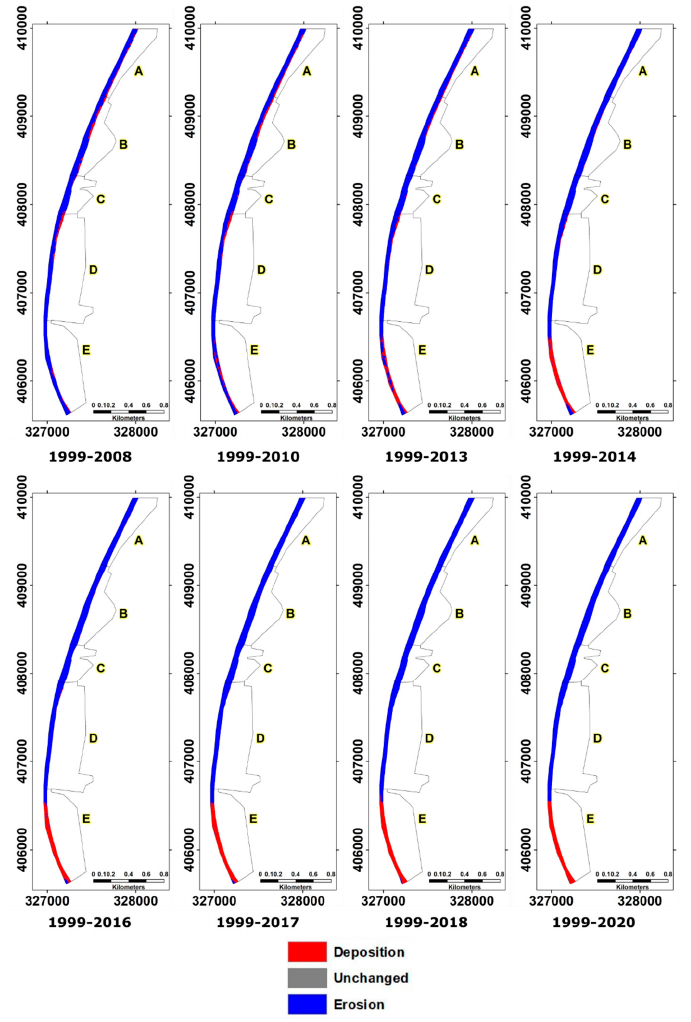
Figure 6. Deposition and erosion maps of the beach. This figure shows the volumetric changes and areas of deposition and erosion on the beach of Formby. Zone E has had an increase in sand volume due to sand deposition. This started occurring from 2010 onwards, while the rest of the beach areas were losing sand. The erosion of the beach shows that any volume of sand lost from the beach is generally not being recovered, with increased flux of sand into the coastal system.